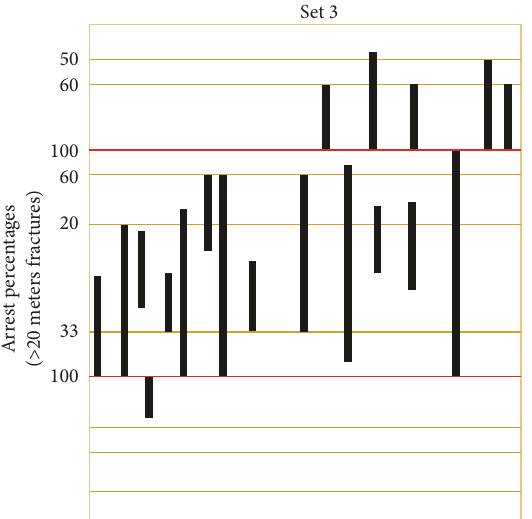
Figure 3: Set 3-joint digitalization and identification of through- going fractures and major mechanical boundaries (from